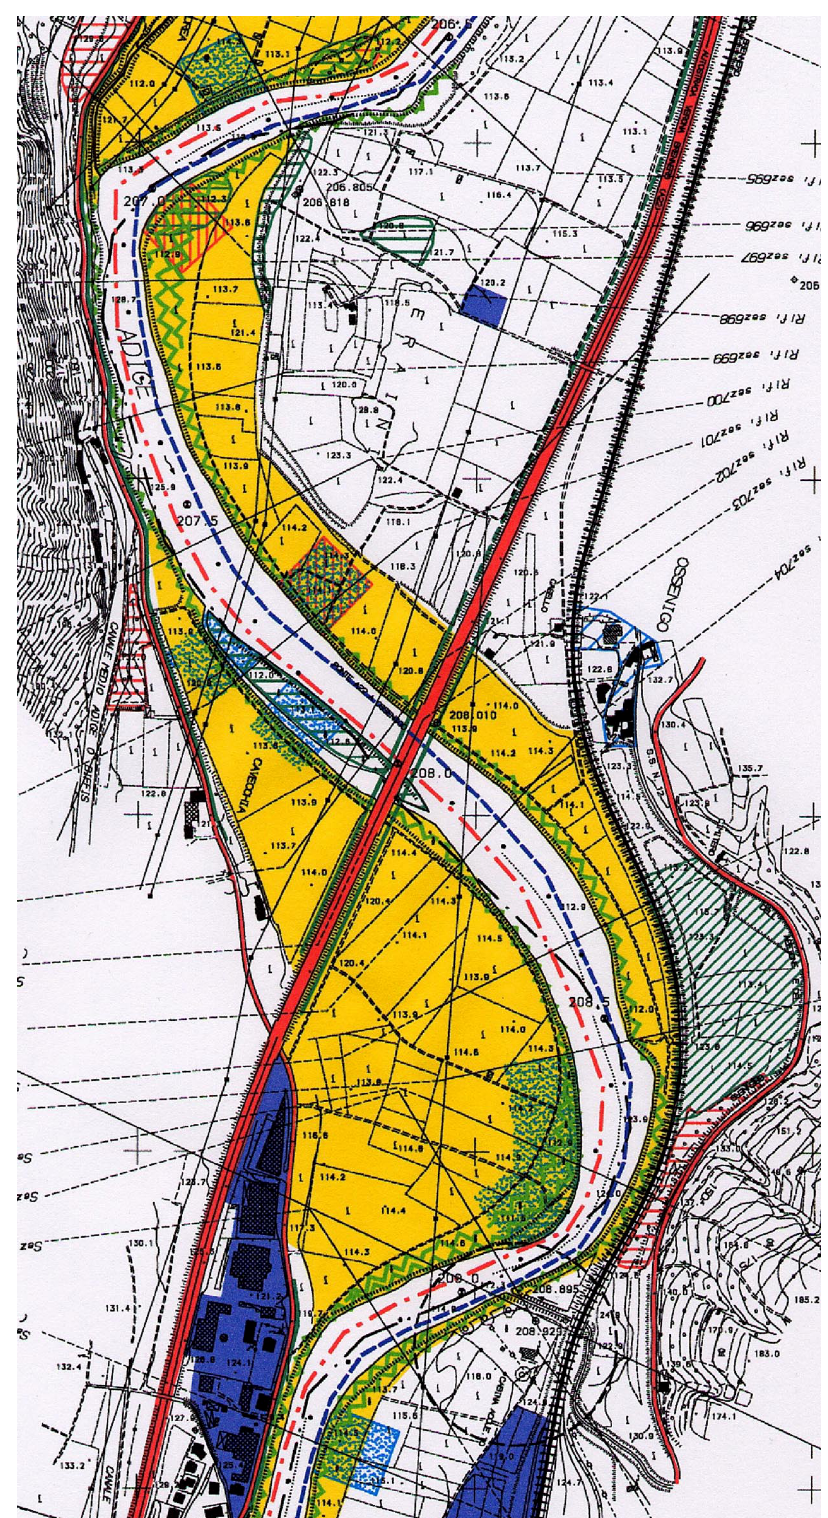
FIGURE 8. Map of quality, degradation, and risks for stretch 8 (modified from